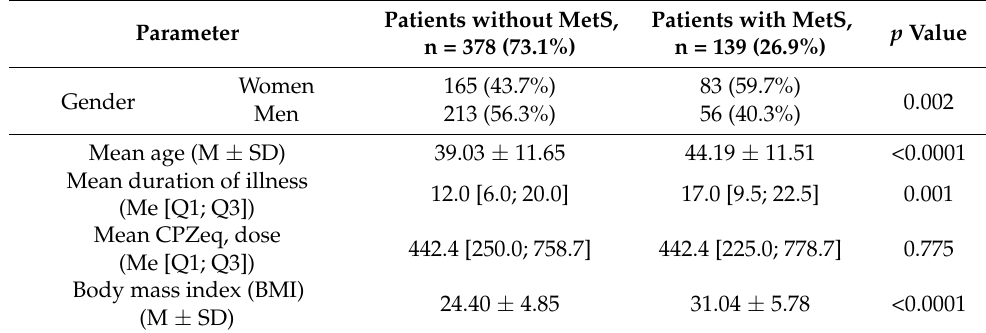
Table 1. Demographic and clinical parameters of the studied patient groups. Patients without MetS, Patients with MetS, p Value Parameter n = 378 (73.1%) n = 139 (26.9%) Women 165 (43.7%) 83 (59.7%) 0.002 Gender Men 213 (56.3%) 56 (40.3%) Mean age (M ± SD) 39.03 ± 11.65 44.19 ± 11.51 <0.0001 Mean duration of illness 12.0 [6.0; 20.0] 17.0 [9.5; 22.5] (Me [Q1; Q3]) Mean CPZeq, dose (Me [Q1; Q3]) Body mass index (BMI) (M ±